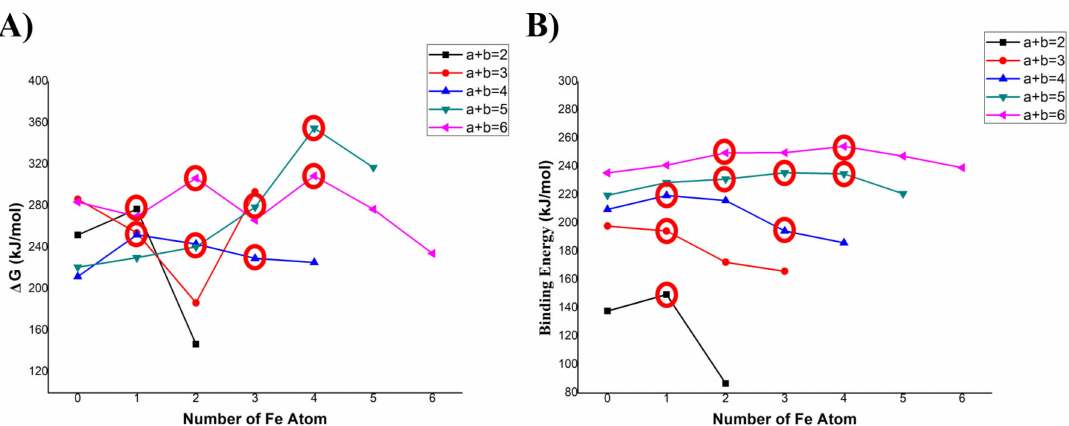
Figure 2. ∆ G ( A ) and binding energy ( B ) of the Ni a Fe b (2 ≤ a + b ≤ 6) clusters versus number of Fe atoms in the